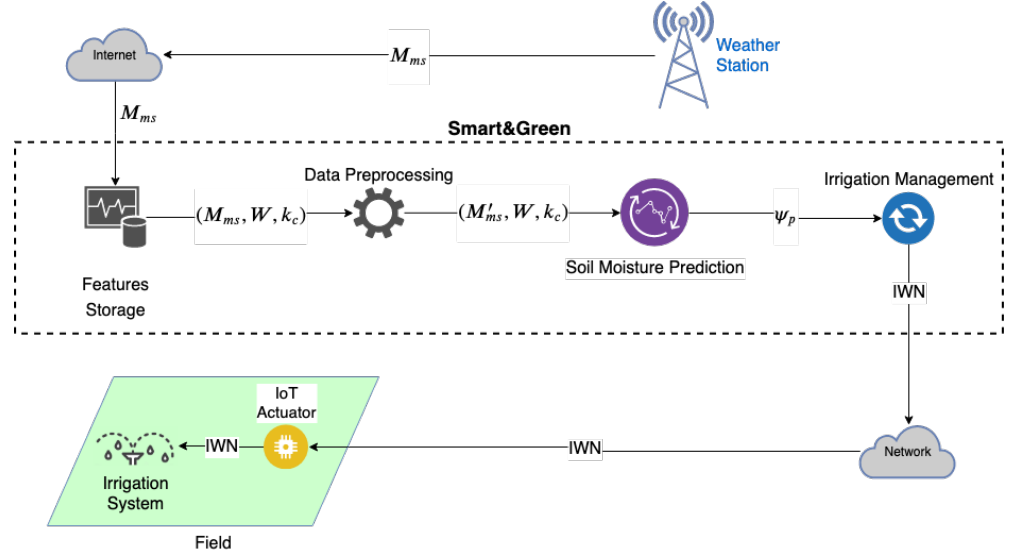
Figure 2. Smart&Green Module for soil moisture